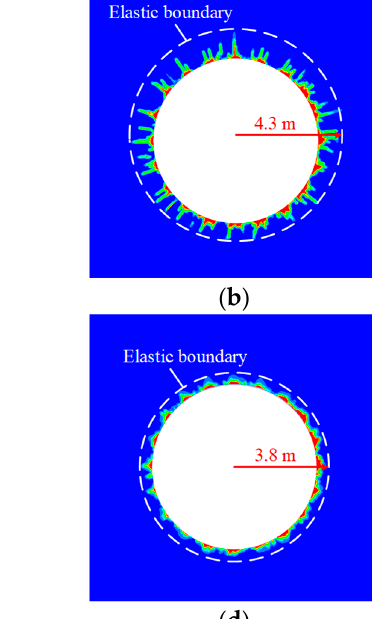
Figure 6. Distributions of the fractured zones caused by blasting under varied hydrostatic in situ stress levels: ( a ) σ x = σ y = 0 MPa; ( b ) σ x = σ y = 10 MPa; ( c ) σ x = σ y = 30 MPa; ( d ) σ x = σ y = 60 MPa.